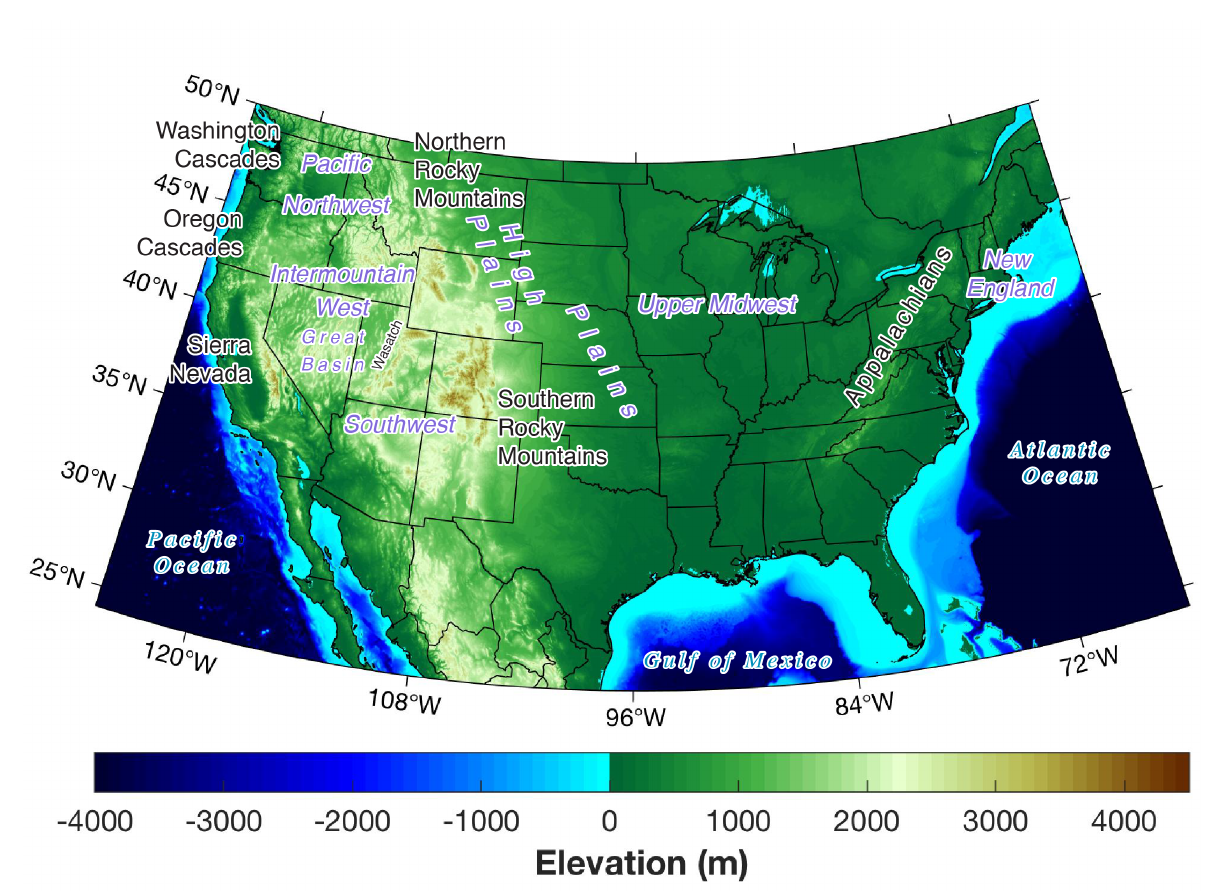
Figure 1. Topography of the conterminous U.S. and surrounding ocean bathymetry from the 1 arc-minute ETOPO digital elevation map [53]. Regions (light purple italicized text) and mountain ranges (black standard text) discussed in the main text are